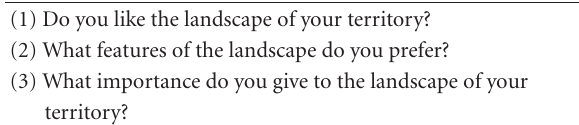
Table 5: Questions in Section 2.2.3.